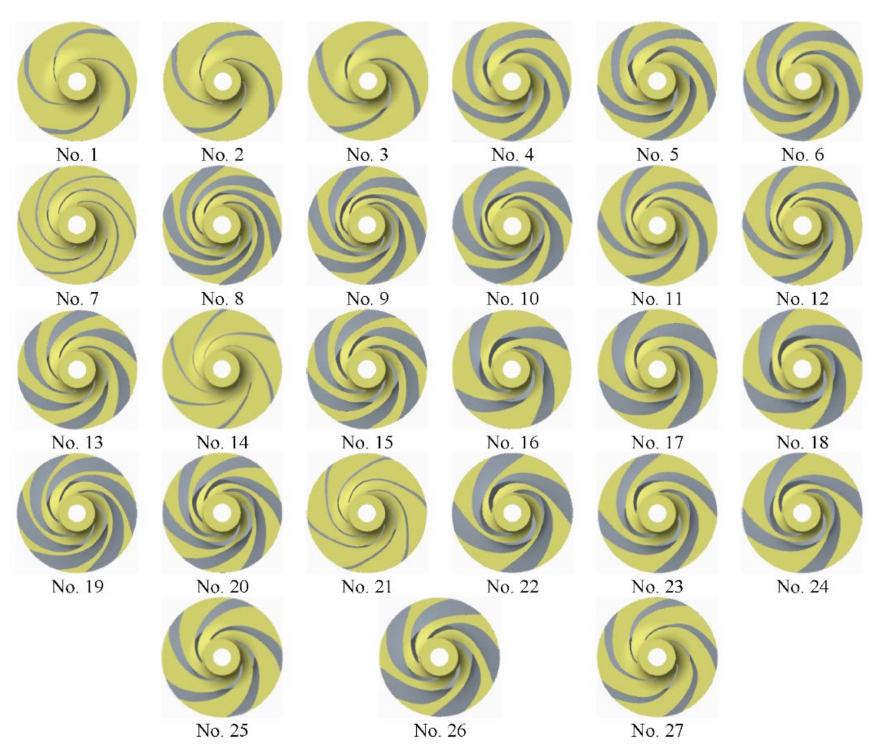
Figure 8. 3D models of 27 impellers from the orthogonal